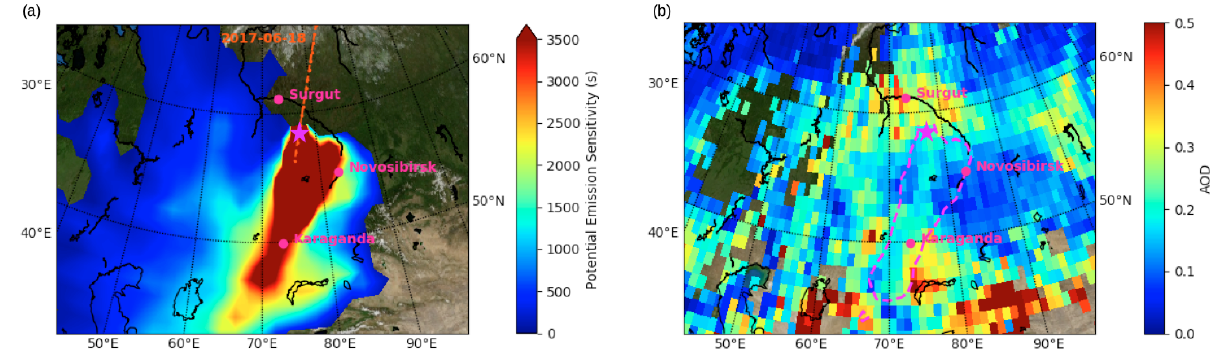
Figure 8. ( a ) as Figure 4a for the aerosol layer of Figure 7. Orange dotted line is the position of the CALIOP overpass on 18 June 2017. ( b ) as Figure 4b with averaging of MODIS AOD 550 from 15 to 18 June